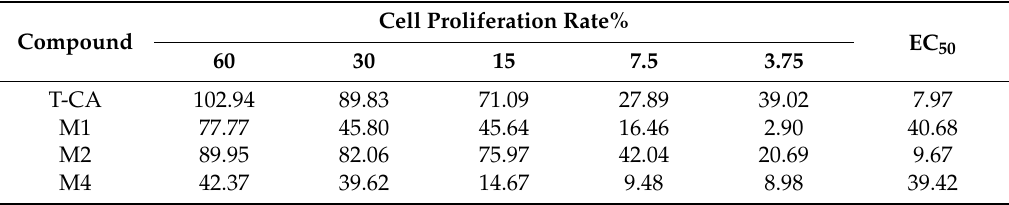
Table 2. Neuroprotective activity of metabolites M1, M2, and